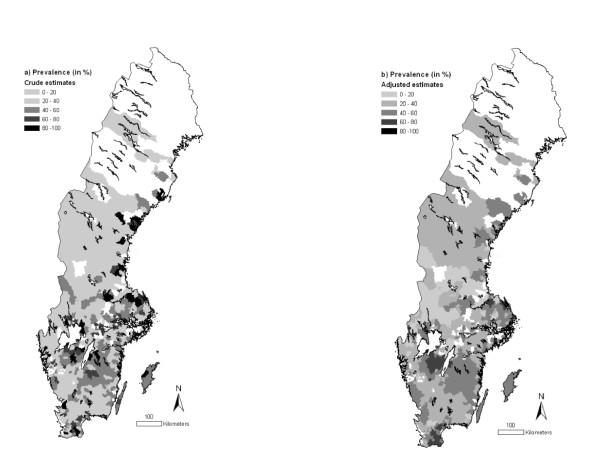
Prevalence of BRSV in Swedish beef cattle by three-digit postal code area (2007). The estimates are (a) crude or (b) adjusted by empirical Bayes smoothing applying a spatial weight matrix. Information was missing for the white areas. © Lantmäteriverket Gävle 2010. Permission number I 2010/0055.